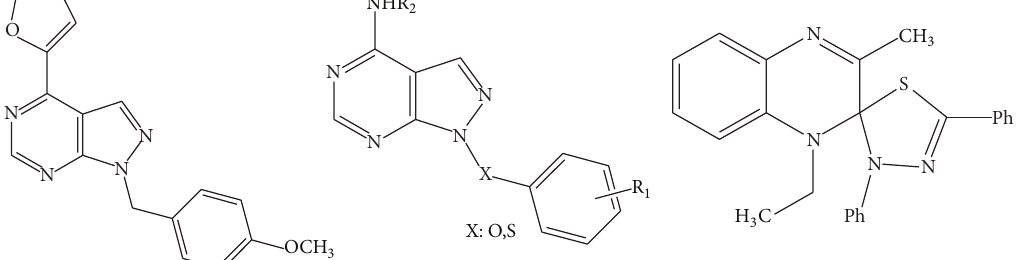
Figure 1: Pyrazolopyrimidine containing drugs.